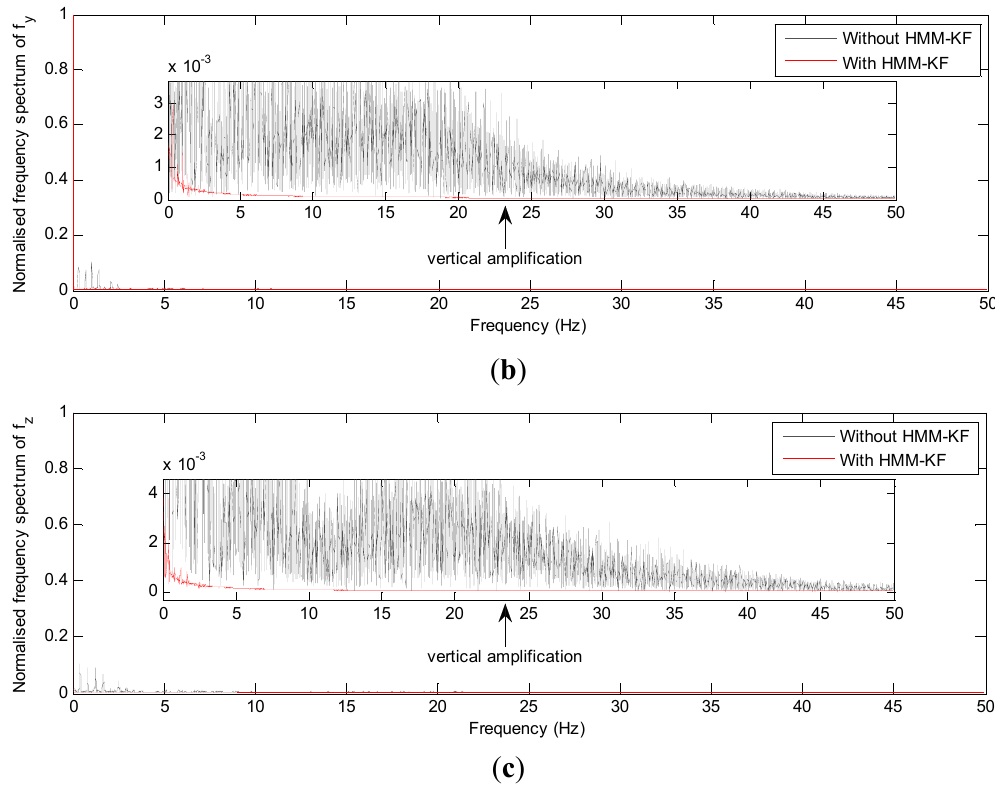
Figure 7. Frequency-domain analysis of the gyroscope outputs with and without